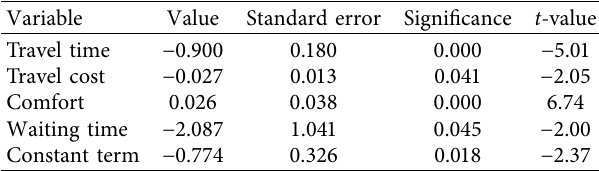
Table 4: Calibration results for equation